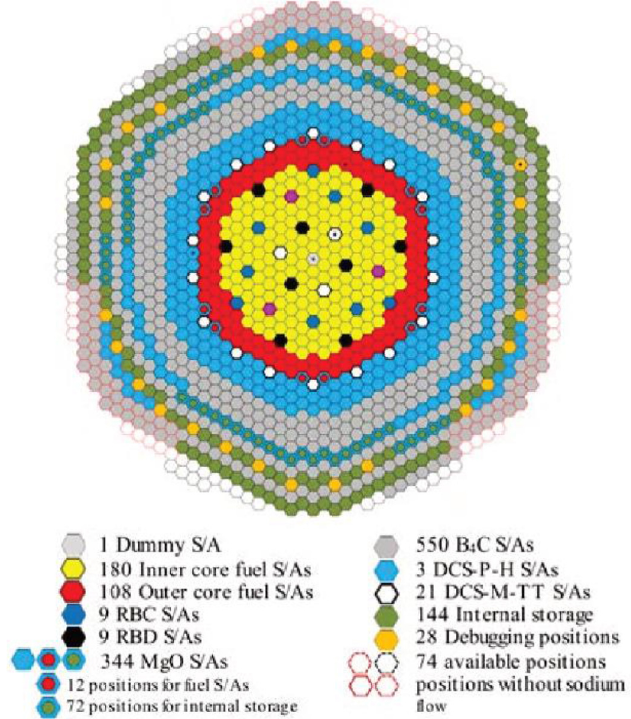
Fig. 3. Loading pattern of the ASTRID reactor.